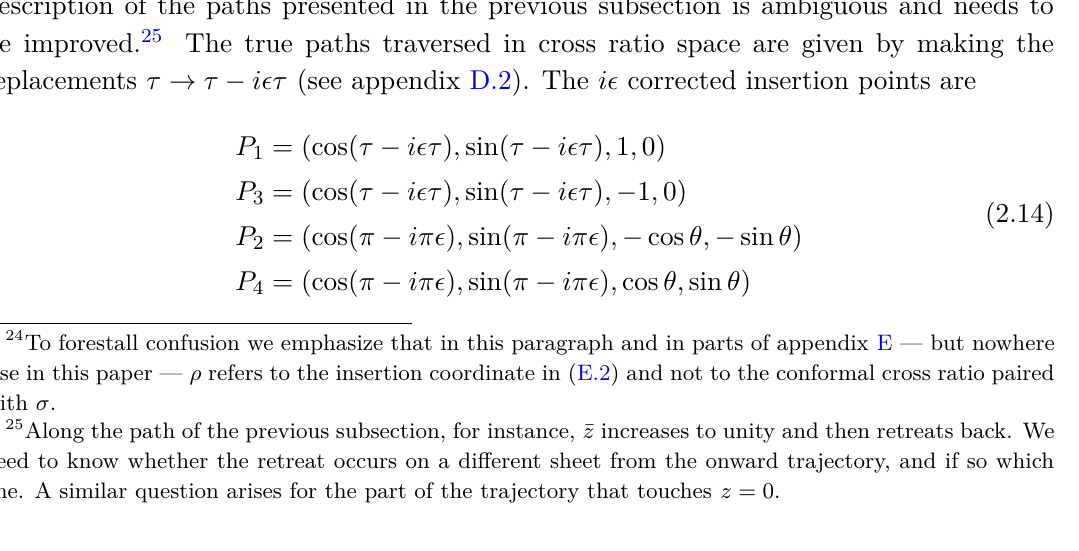
Figure 4 . The evolution of the cross ratio e 2 ρ = z Note that e 2 ρ touches its minimum value, e 2 ρ = 0 at τ = θ , when z